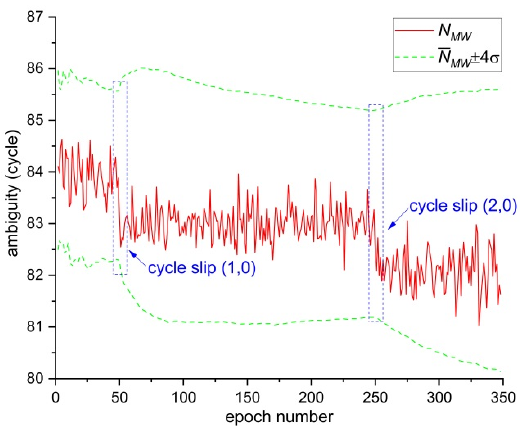
Figure 2. Results of conventional MW combination detection of small cycle slips.